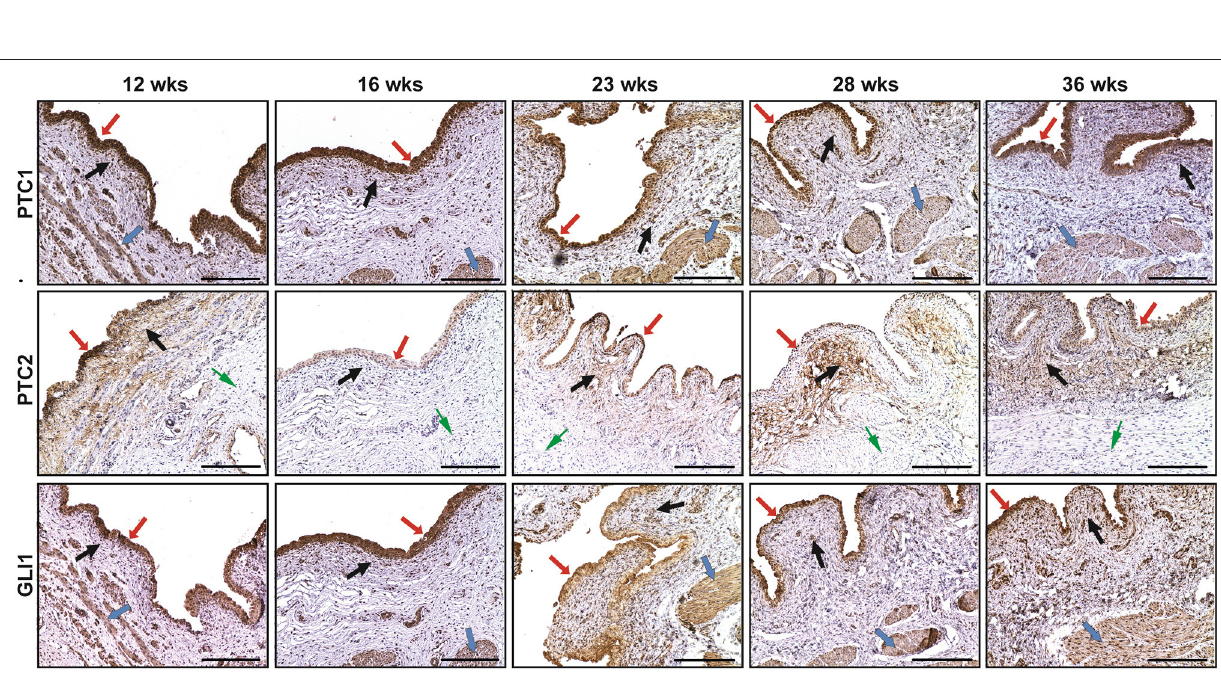
Frontiers in Pediatrics |